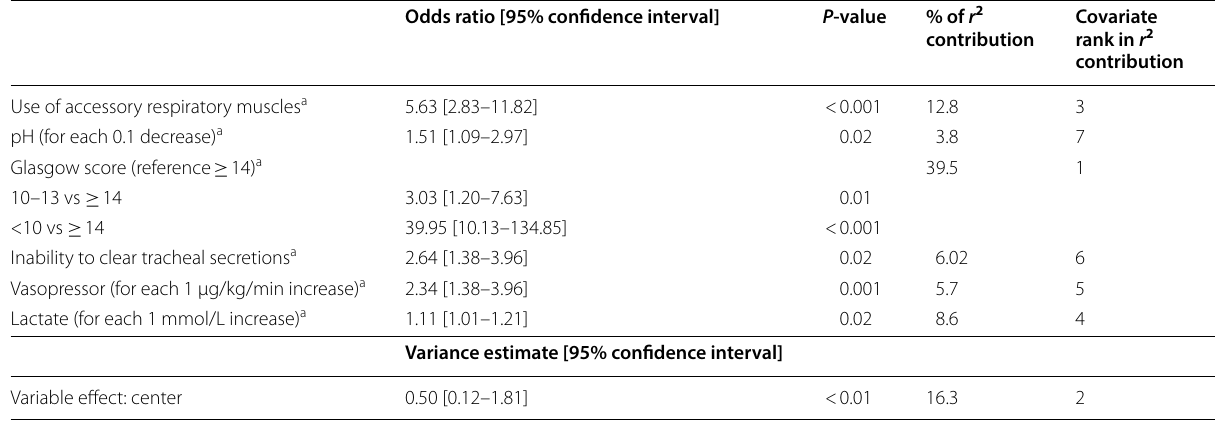
Overall r 2 of the model was 0.6